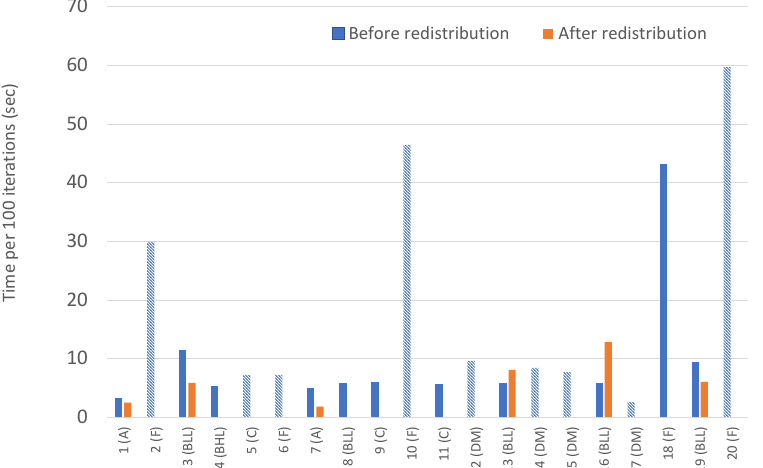
Figure 10. Framework evaluation for Scenario B. Each bar shows the execution time per 100 iterations of each application. Applications with striped bars are applications that create interference. Applications with two bars exhibit change in the execution time due to interferences.